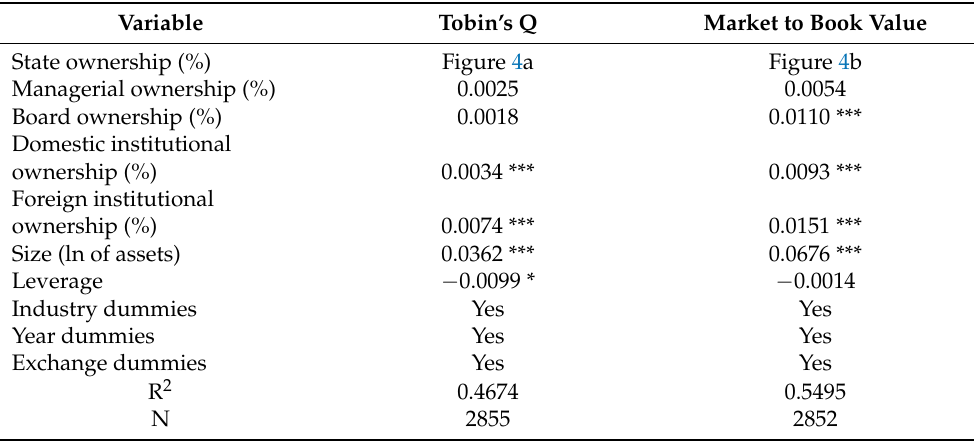
Table 5. IV Semiparametric regression models of partially privatized firm market performance on residual state